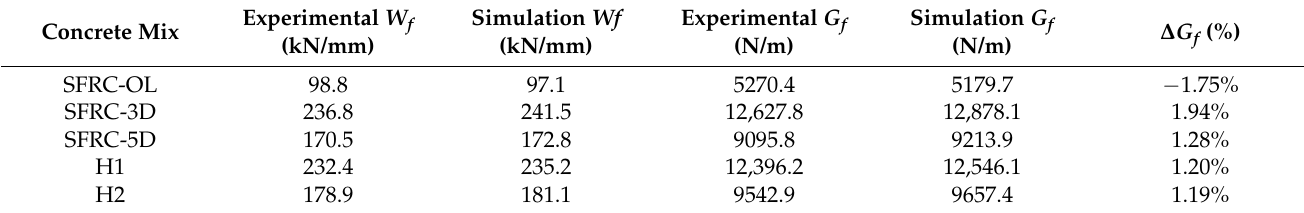
Table 5. Comparison of the experimental and simulated fracture energies at a deflection of 10